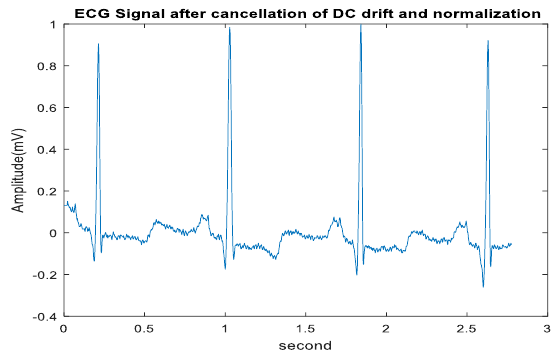
Fig. 3. The first 3 seconds of the apnea ECG from an example